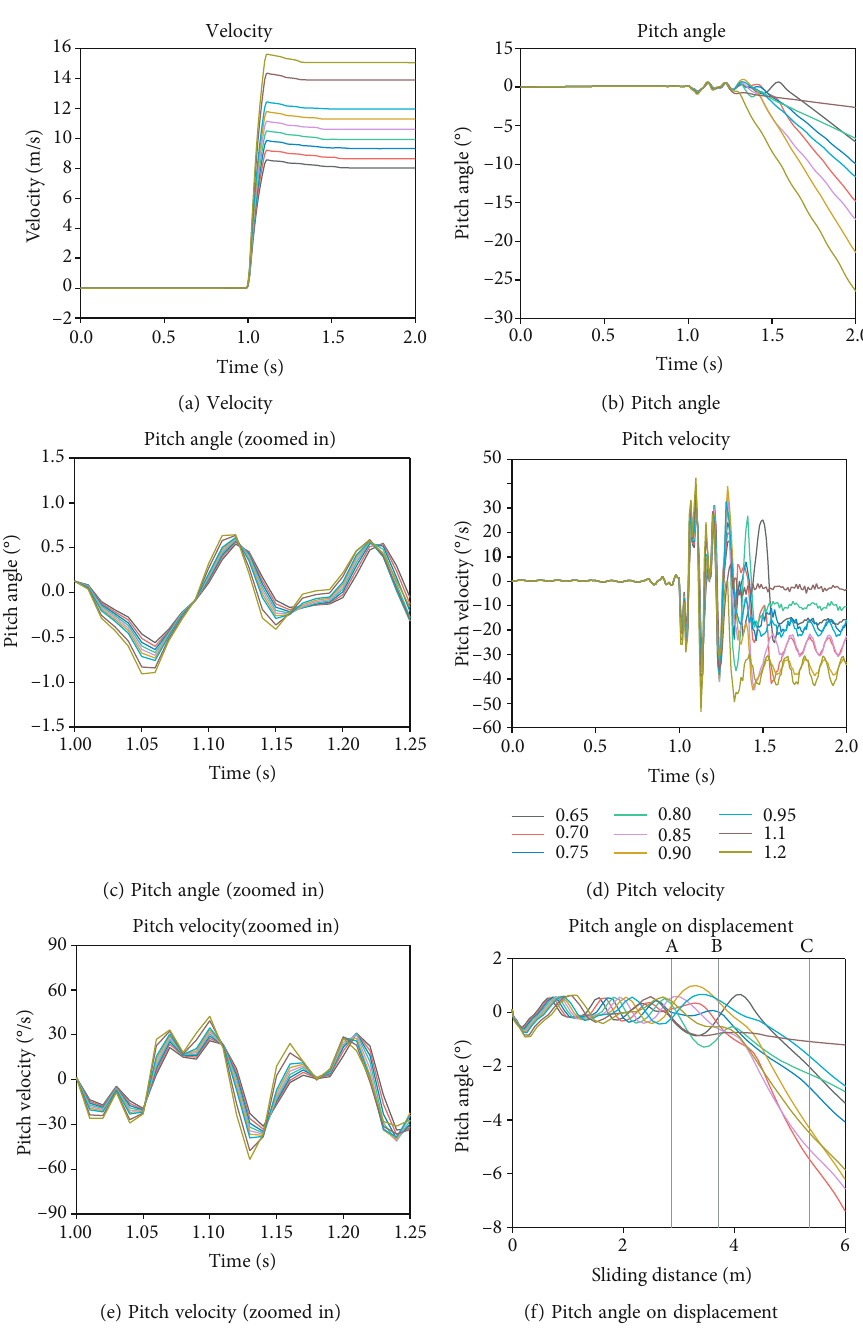
Figure 9: Comparison of missile movement under di ff erent ejection